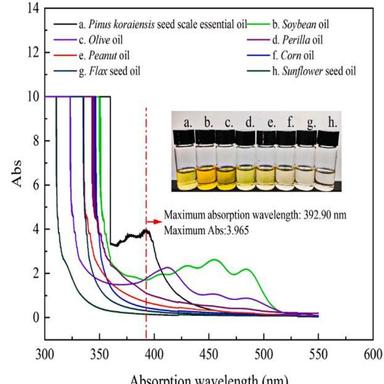
UV full-wavelength scanning spectra of the different plant oils.